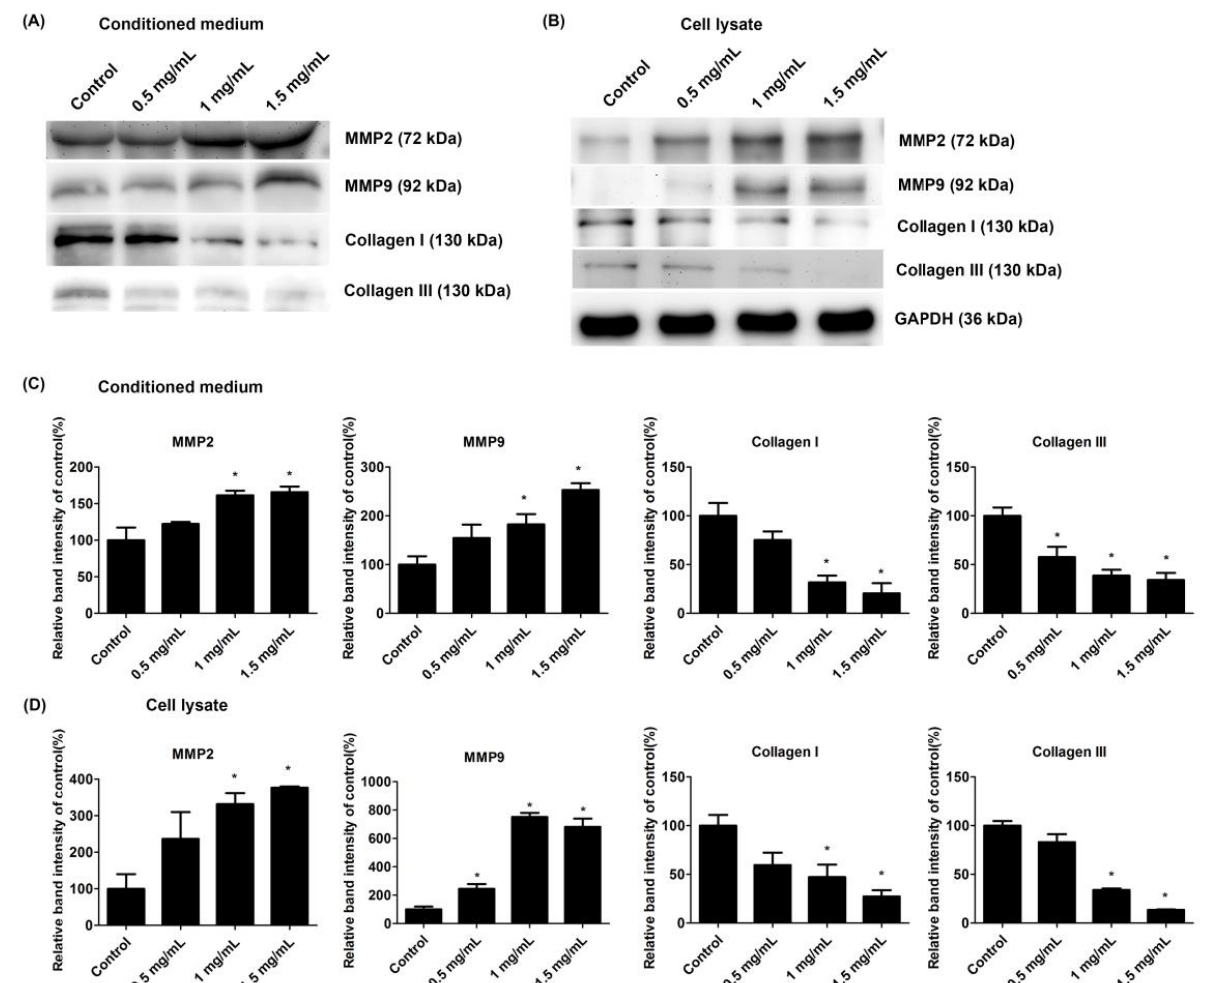
Figure 7. Lidocaine changed MMP expression and altered collagen production in tendon cells. Western blot analysis of the expression of MMP-2, MMP-9, type I collagen, and type III collagen in ( A ) conditioned medium and ( B ) cell lysate. ( C , D ) Densitometric analysis of MMP-2, MMP-9, type I collagen, and type III collagen. The loading volume of the conditioned medium was adjusted by the number of cells in the control, 0.5 mg/mL, 1.0 mg/mL, and 1.5 mg/mL groups. The GAPDH was used as the internal control in the cell lysate group. The data of the densitometric analysis of were normalized to the GAPDH in cell lysate group. Data are presented as the means ± standard errors of the mean of three independent experiments. * p < 0.05.